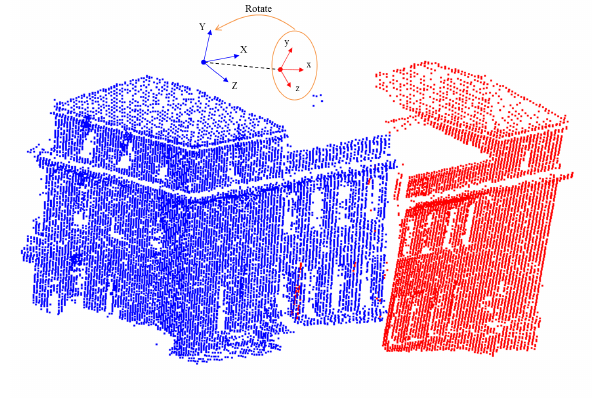
Figure 2: Scanned building with separate scans with the mis- aligned scan needing to be